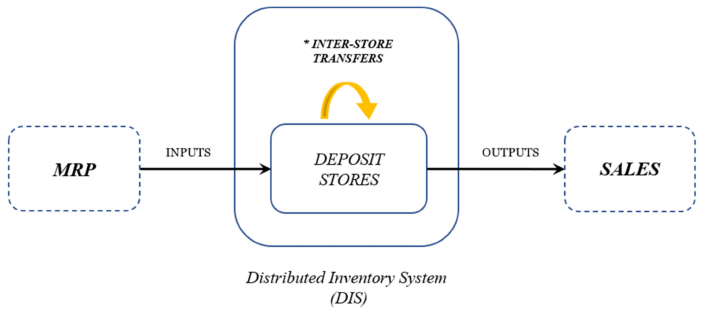
Figure 17. Conceptual Model—Interaction Plane (CM-S). * Inter-store transfers not applicable to all stores.